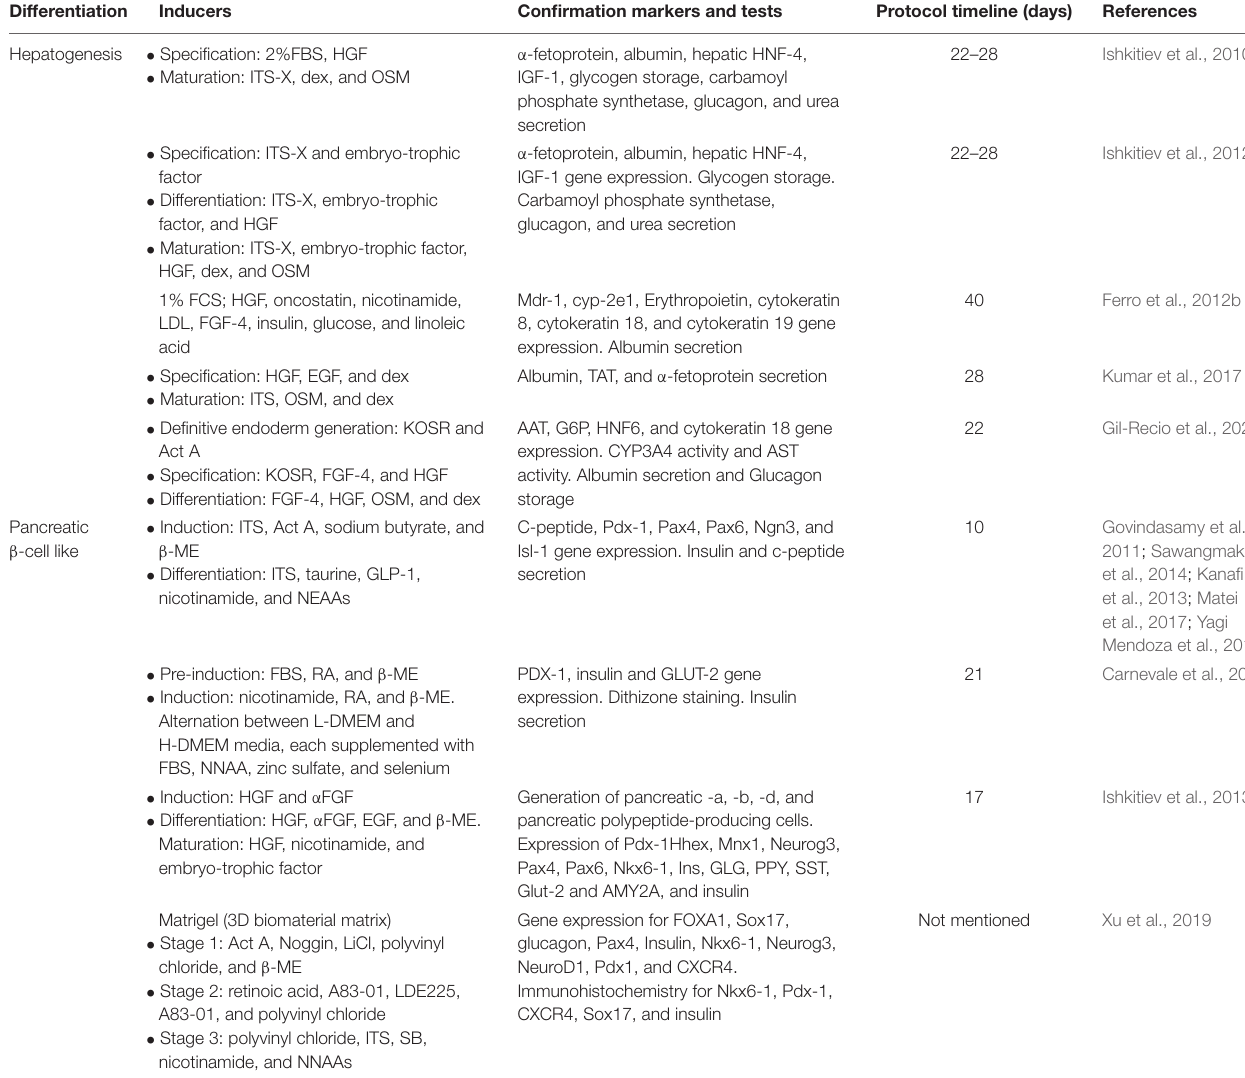
TABLE 2 | Protocols and composition of media used by different studies to generate hepatocytes and insulin producing pancreatic β -cells from DPSCs. Differentiation Inducers Confirmation markers and